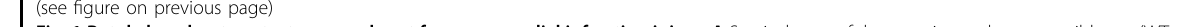
Fig. 1 Retnla knockout protects mouse heart from myocardial infarction injury. A Survival rates of the experimental groups; wild type (WT, n = 15) mice and Retnla knockout (KO, n = 17) mice with or without myocardial infarction (MI). WT MI n = 47, KO MI n = 36. B Left ventricular ejection fraction (LVEF) was determined by echocardiography in Retnla KO ( n = 19) and WT littermates ( n = 18) 14 days after MI. C Heart weight/body weight (HW/BW) ratios of mice were calculated before and at 14 days after MI. (WT; n = 7, KO; n = 7, WT MI; n = 18, KO MI; n = 16). D Cardiomyocyte apoptosis (white arrows) in the peri-infarct area was determined by TUNEL staining. cTnI cardiac troponin I. Scale bar, 200 μ m. (WT; n = 7, KO; n = 7). E In fl ammation-related mediators were analyzed by using antibody array membranes. F Three days after MI, cardiac macrophages were isolated to compare the cell number and phenotype. Ly6G( − )CD11b( + )F4/80( + )CD11C( − ) cells are pro-in fl ammatory macrophages and Ly6G( − )CD11b( + )F4/ 80( + )CD206( + ) cells are anti-in fl ammatory macrophages. The number of Ly6G( − )CD11b9( + )F4/80( + ) cardiac macrophages was higher in the KO mice ( n = 3, three mice per sample each) than in the WT mice ( n = 3, three mice per sample each). G Angiogenesis-related mediators were analyzed by using antibody array membranes. H Micro fi l perfusion of hearts from WT and Retnla KO mice with MI for 14 days. I Left ventricular vascularity was assessed by immunostaining of von Willebrand factor (vWF) and α -smooth muscle actin ( α -SMA). Representative images of vWF stained capillaries and α -SMA( + )-vessels in the infarcted heart. (WT; n = 7, KO; n = 10). Scale bar, 100 μ m. J Representative Masson ’ s trichrome staining images of WT ( n = 17) and Retnla KO mice ( n = 15) after 14 days of MI. Quantitative analysis of ventricular fi brosis (expressed as a percentage of total left ventricular area) in WT and KO. Scale bar, 1000 μ m. EF ejection fraction, FS fractional shortening. Data are represented as mean ± SEM. # P < 0.05, ## P < 0.01, ### P < 0.001 (by Student ’ s t